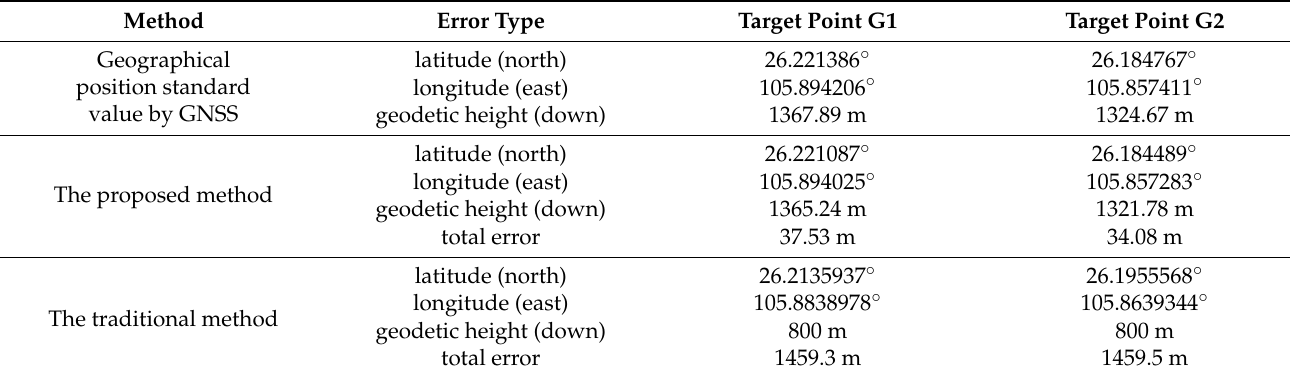
Table 6. Geo-location error results in the flight